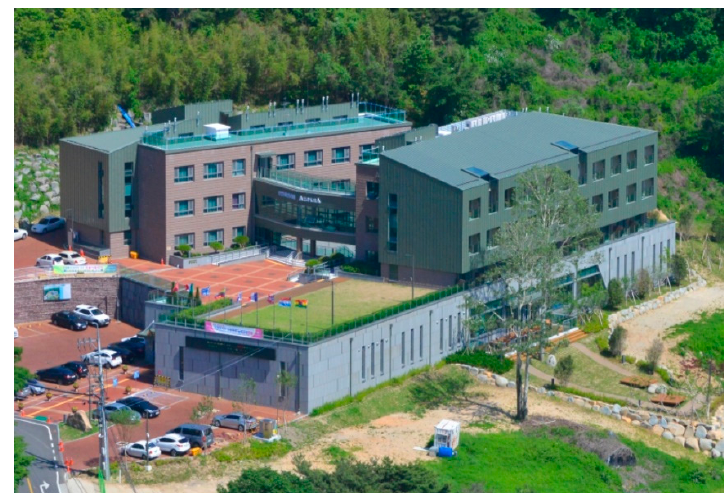
Figure 4. The test hotel in Daegu, South Korea.